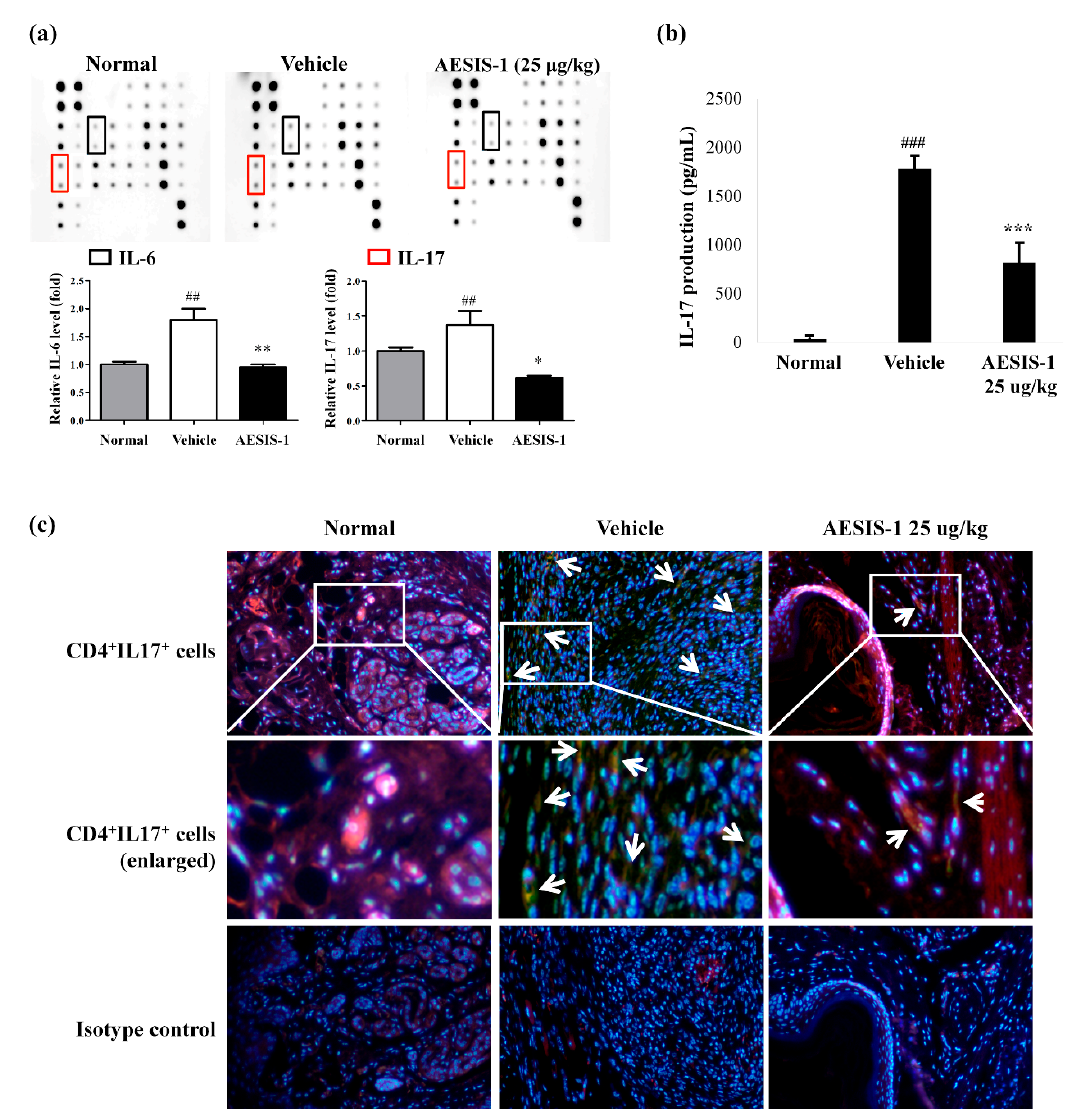
Figure 4. AESIS-1 suppressed IL-17 production and Th17 cell distribution in CIA mouse model. ( a ) To detect IL-6 and IL-17 levels, a cytokine array was performed using the mouse sera collected from normal, vehicle, and AESIS-1 groups. The intensity of each spot was then quantified using ImageJ software. The relative protein level was set to 1 for normal control; ( b ) To measure the levels of IL-17 production, splenocytes were isolated from vehicle- or AESIS-1-treated CIA mice. The cells were stimulated with CII (20 μ g/mL) for 24 h, and then ELISA was performed to detect IL-17 levels in the cultured supernatant. ANOVA with Tukey’s post hoc tests was used for statistical analysis. ## p ≤ 0.01 and ### p ≤ 0.001, compared with normal control. * p ≤ 0.05, ** p ≤ 0.01, and *** p ≤ 0.001, compared with vehicle (PBS) group; ( c ) To detect CD4 + IL-17 + Th17 cell distribution in the tissues, immunofluorescence staining was performed using rat anti-mouse CD4 Ab and rabbit anti-IL-17 Ab as primary antibodies. Alexa-594-conjugated Rat IgG and FITC-conjugated Rabbit IgG antibodies were used then for CD4 and IL-17, respectively. Nuclei were stained by Heochst33258. Rabbit IgG or rat IgG were used as isotype controls. White arrows indicate double-stained cells. Photographs are of representatives of each group (original magnification ×200). To further identify the direct effects of AESIS-1 on Th17 cells, lymphocytes were isolated from lymph nodes of DBA/1J mice, and naïve CD4 + T cells were then purified from the isolated